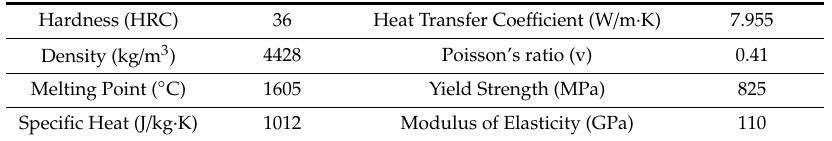
Table 1. Physical properties of Ti6Al4V.